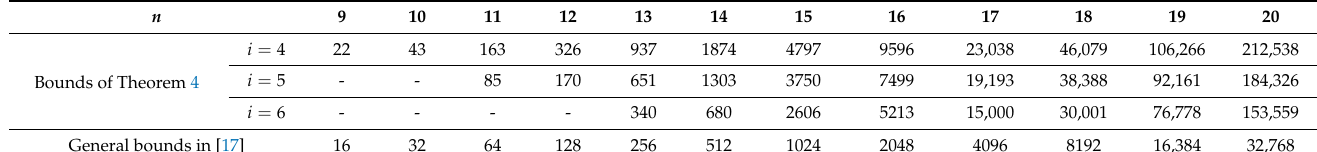
Table 2. Bounds due to Theorem 4 and [17] for n ≥ 9, and n ≥ 2 i with i an integer.